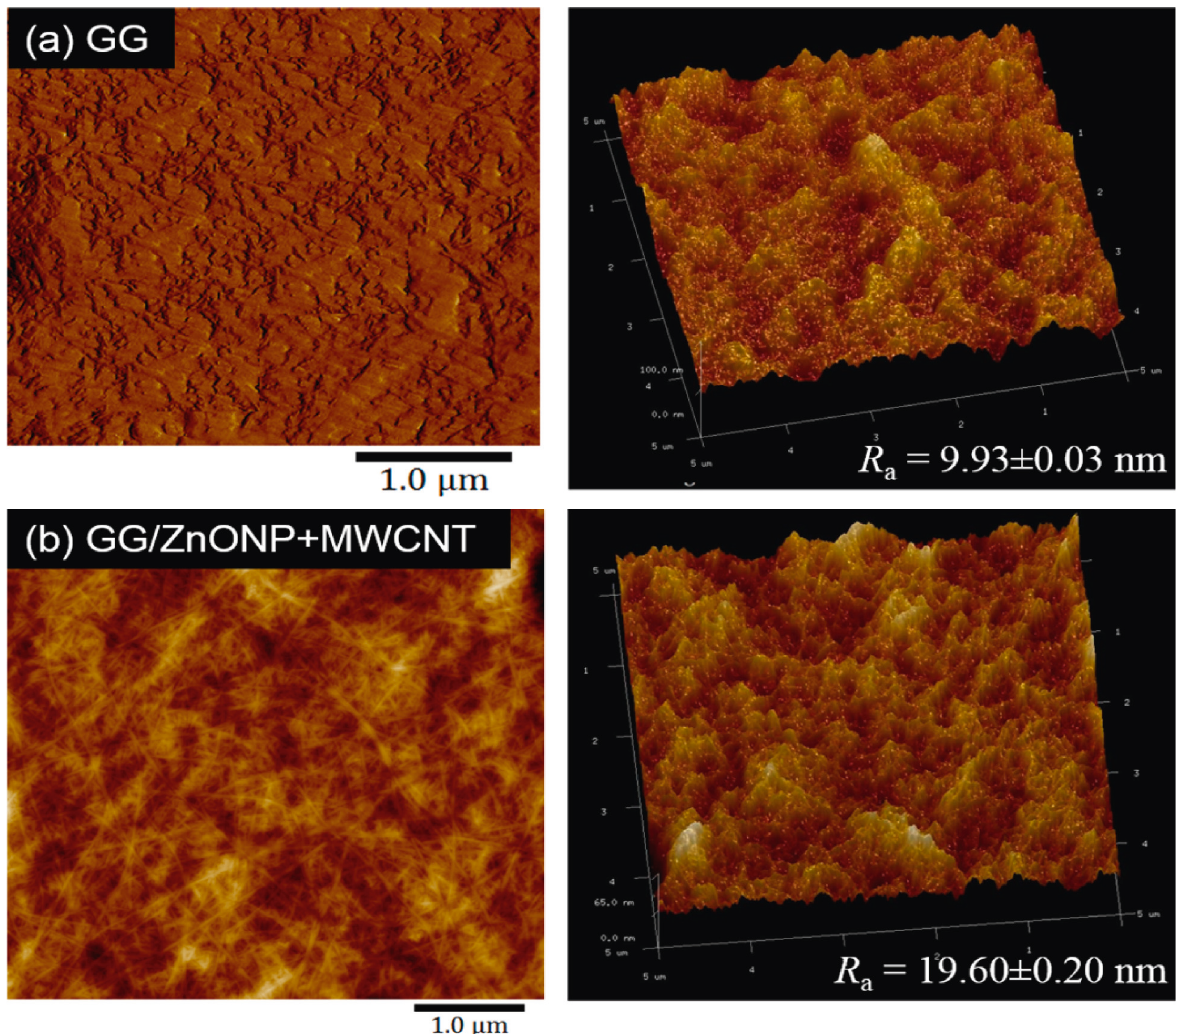
Figure 6: Three-dimensional (3D) height images of AFM of (a) pure GG film and (b) GG/ZnONP +MWCNT bionanocomposite